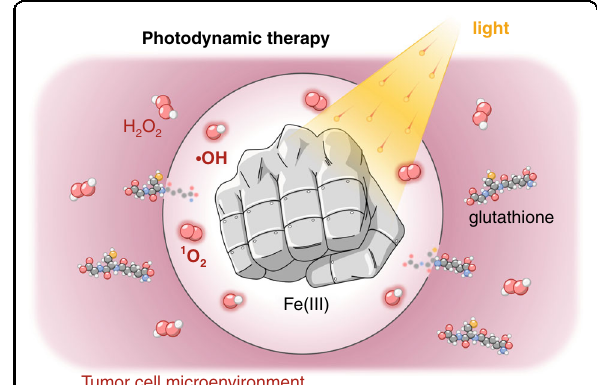
Fig. 1 An “ iron fi st ” to boost the performance of PDT. A pictorial representation of the action of Fe(III) in carbonized-hemin nanoparticles during PDT in terms of supporting ROS generation from H 2 O 2 and glutathione